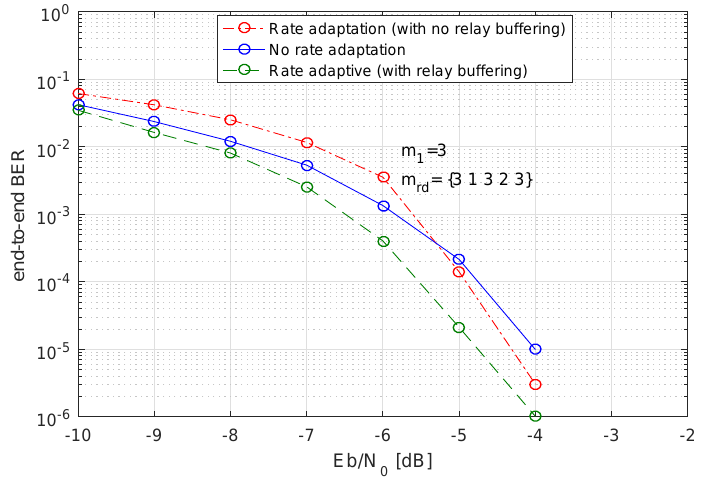
Figure 8. BER of multiple relays with equal transmit power = 1/2, code rate = 1/2, code length = 648, and